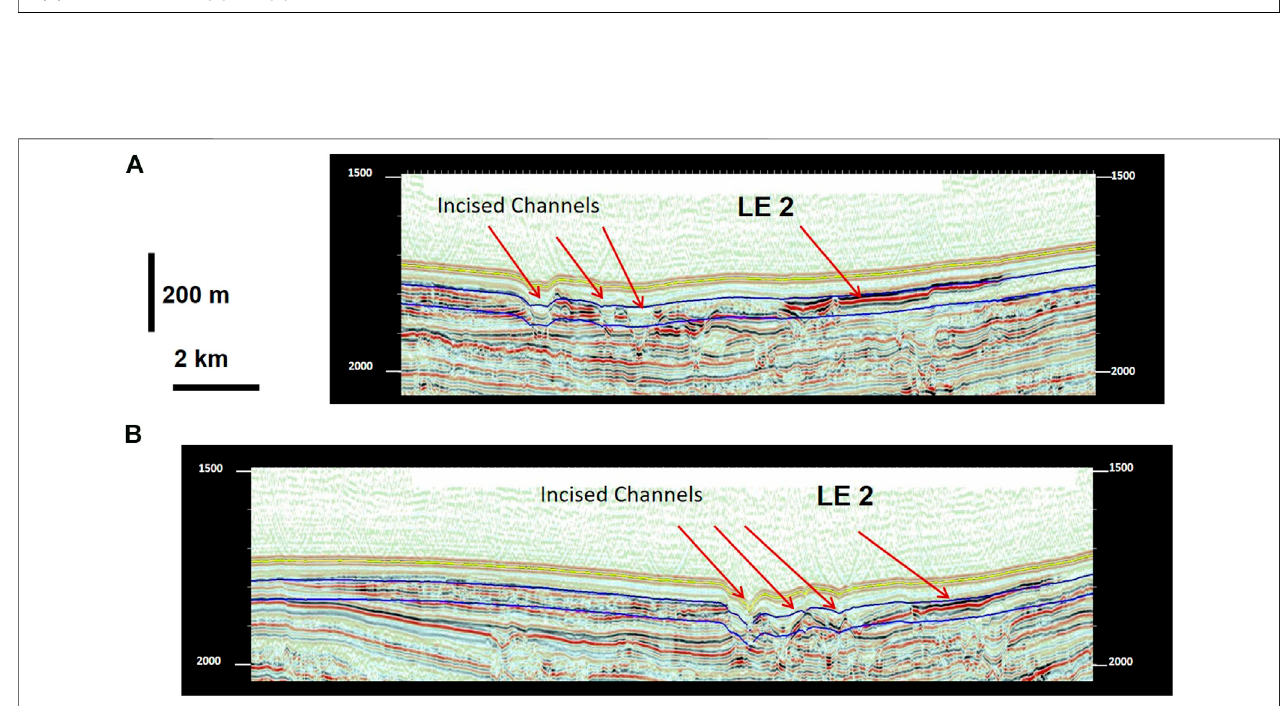
FIGURE7| CrosssectionsthroughLE2froma3Dre fl ectionseismicvolume.See Figure6 forlocations.Thebluelinesindicatethetopandbaseoftheintervalfrom which the RMS (Root Mean Squared) values in Figure 6 were calculated. (A) Seismic section through the distal portion of LE2. This portion of the lobate deposit is characterizedbyhighlycontinuousre fl ections.IncisionalbypasschannelsareevidenttothewestofLE2. (B) SeismicsectionthroughtheterminusofLE2.LE2continues to be characterized by a highly continuous re fl ection. The area to the west of LE2 is dominated by multiple incised channel.